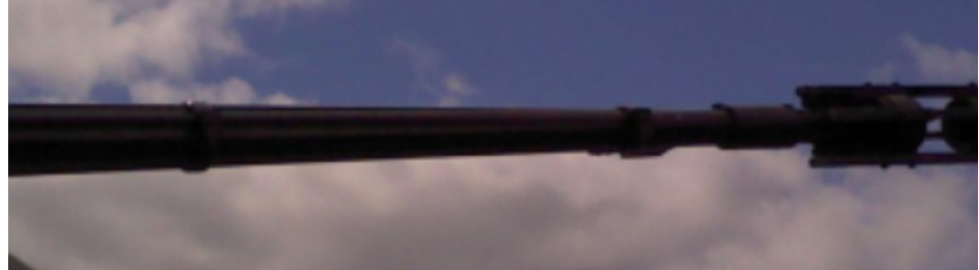
Figure 6. Barrel region investigated using the thermographic camera.